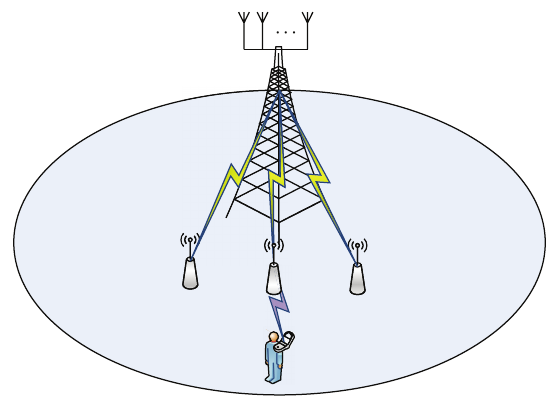
Figure 4: Communication with relay